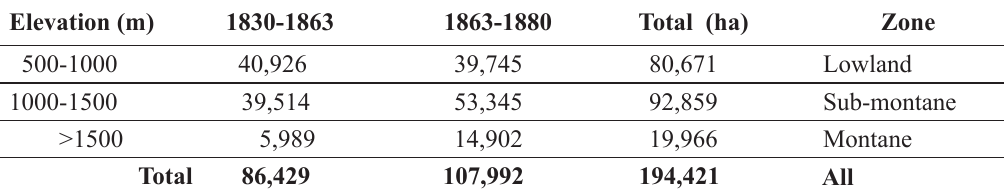
Table 1: Coffee estates by elevation zone and time period (area in ha).